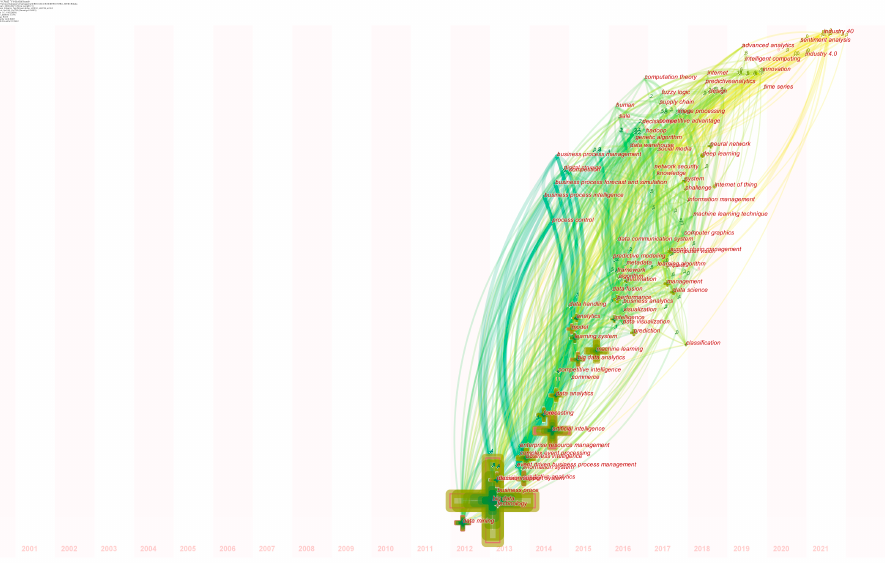
Figure 9. The time zone of hotspots (The cross pattern represents the keyword).